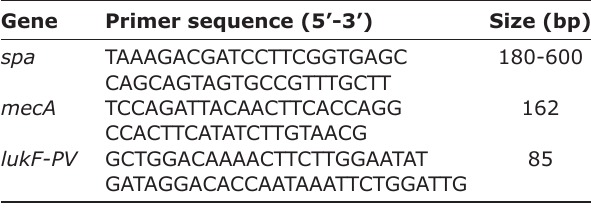
Table-2: Details of the primers used in multiplex PCR